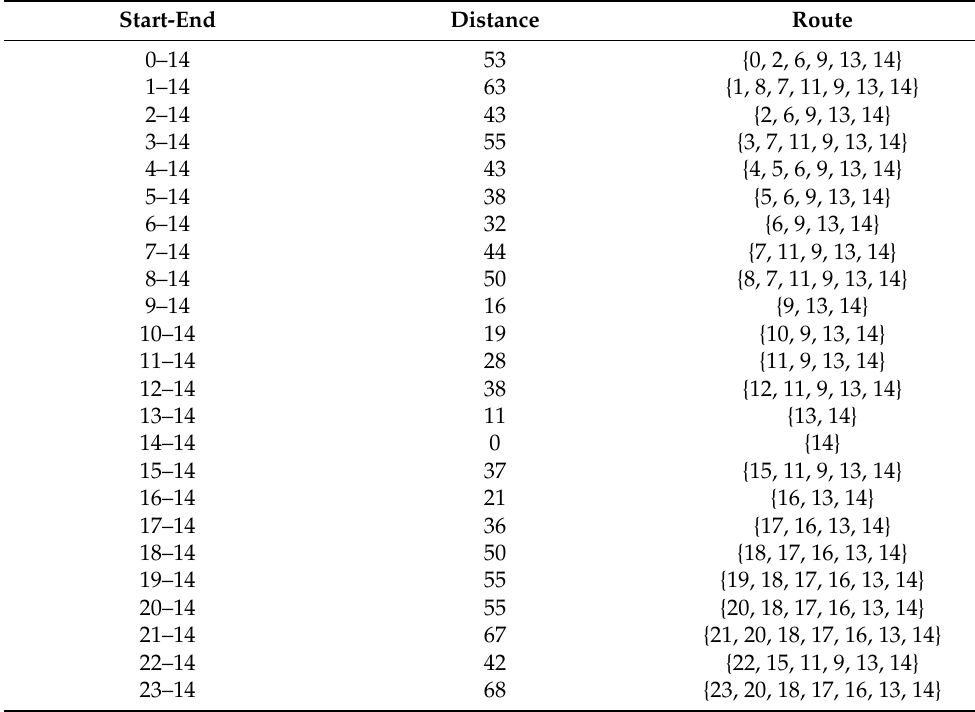
Table 5. The shortest route from each node to the exit